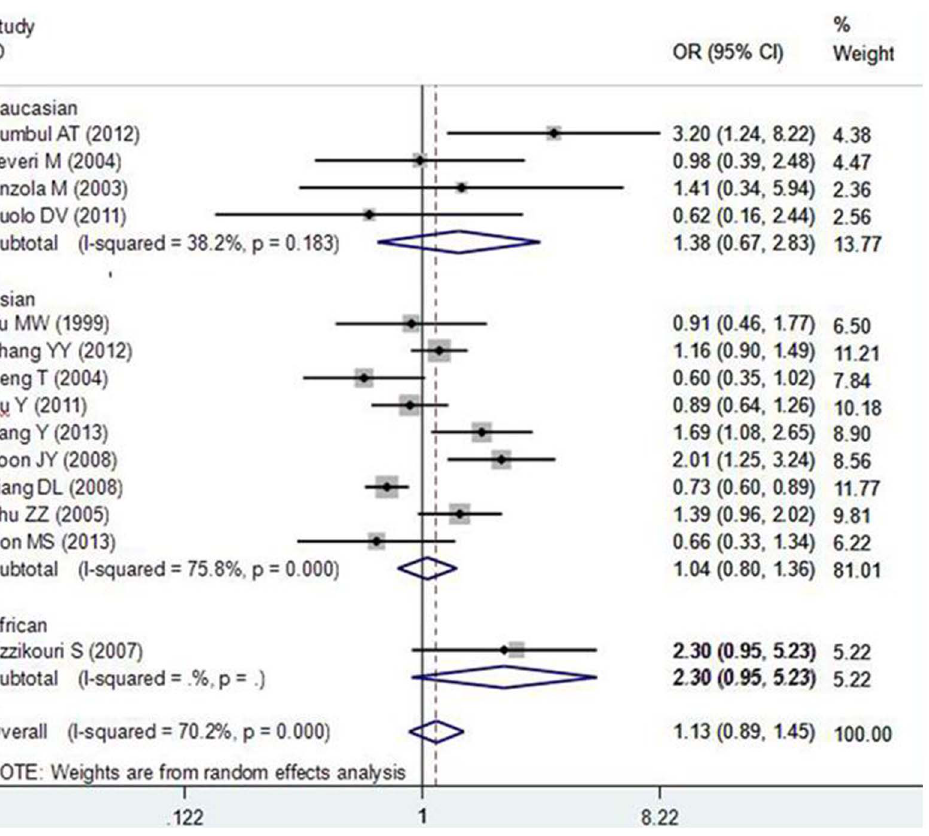
Figure 2. Subgroup analysis by ethnicity in the meta-analysis on the association between TP53 Arg72Pro polymorphism and HCC risk using a random-effect model (additive model ProPro vs. ArgArg).